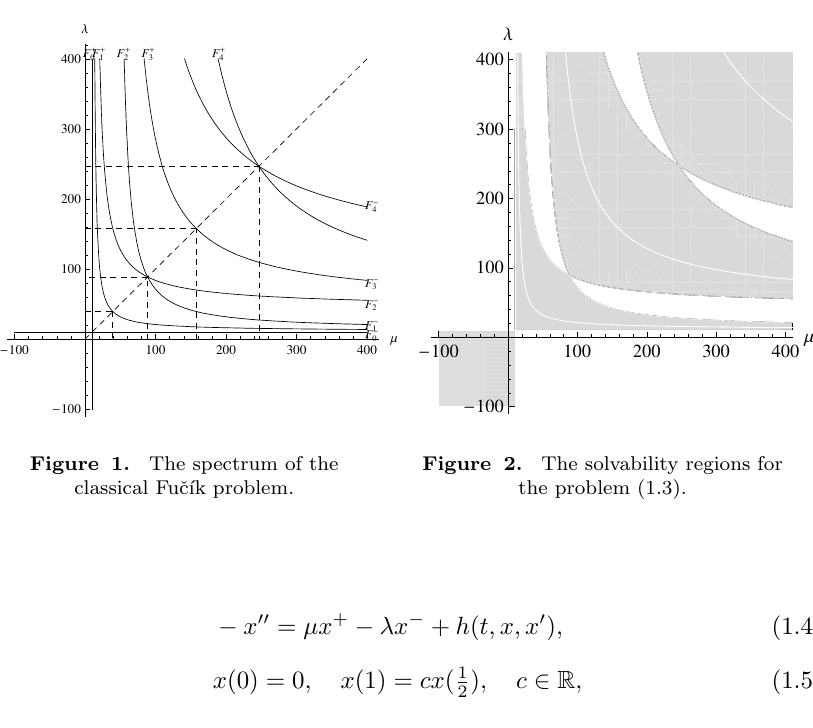
Figure 2. The solvability regions for the problem